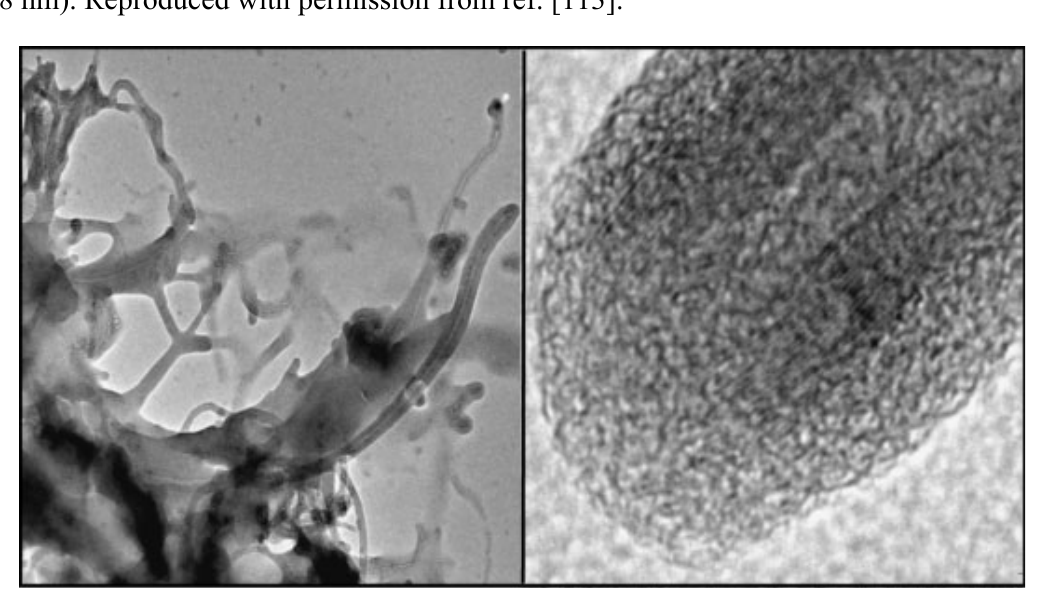
Figure 48. TEM image of polymer encapsulated ox. MWCNTs. Almost every nanotube is covered by a thin and homogenous in situ grown HMWiPP film (left). On the right: TEM images (magnification x 400,000) of an ox. MWCNTs, coated by a thin polymer film (~8 nm). Reproduced with permission from ref. [113].